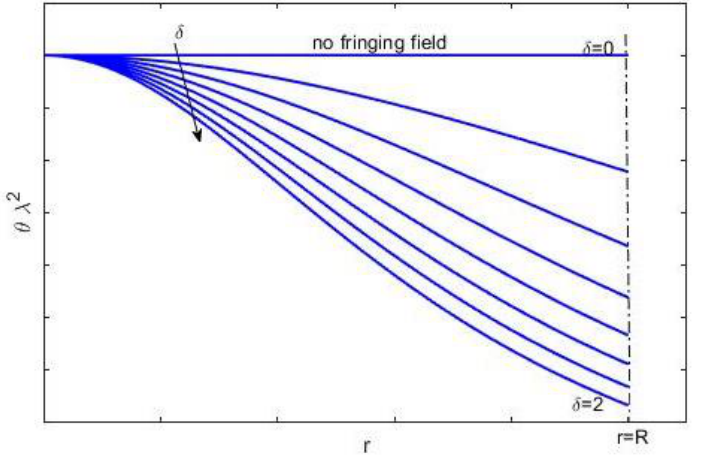
Figure 2. A graphical representation of (8) when δ changes; the forbidden area is located below each curve, while the permitted area is highlighted above each